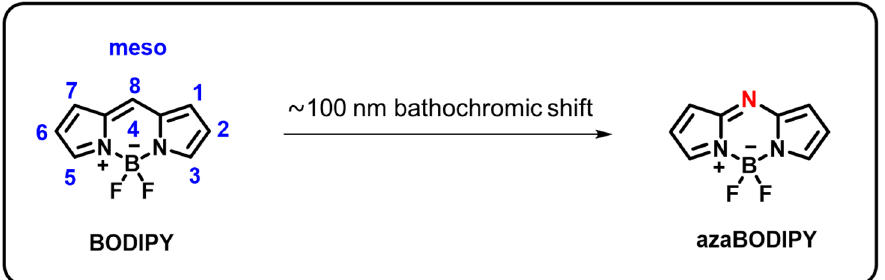
Figure 1. Chemical structure of BODIPY and azaBODIPY.